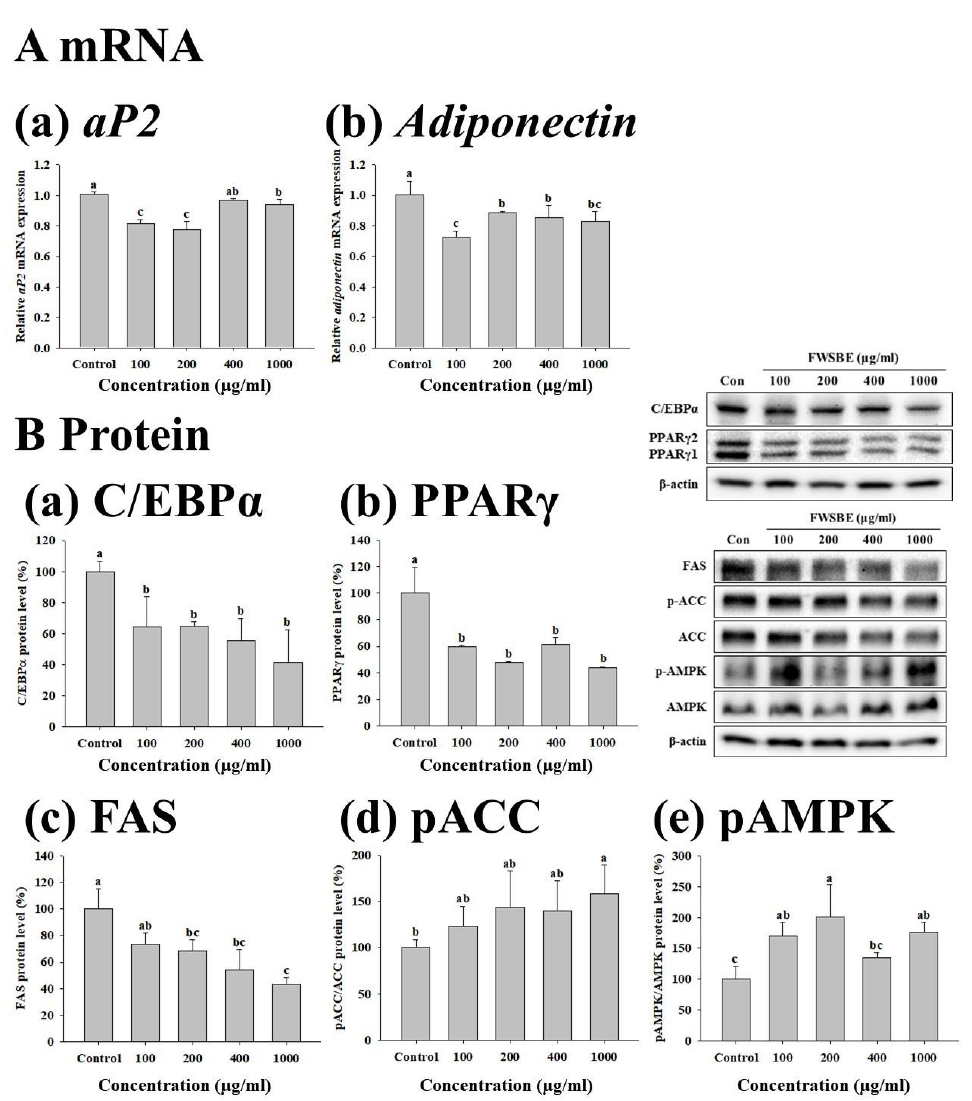
Figure 3. Effects of fermented white sword bean extract (FWSBE) on ( A ) the transcription level of (a) aP2 and (b) adiponectin and ( B ) the protein level of (a) C/EBP α , (b) PPAR γ , (c) FAS, (d) pACC, and (e) pAMPK on 3T3-L1 preadipocytes. The cells were treated with FWSBE at various concentration (100, 200, 400, and 1000 µ g/mL) for 48 h during differentiation. Values are presented as mean ± standard deviation. The statistically significant difference ( p < 0.05) between groups was determined by a one-way ANOVA and Duncan’s multiple range test. Different letters are used to indicate significant differences. C/EBP α , CCAAT/enhancer binding protein α ; FAS, fatty acid synthase; ACC, acetyl-coenzyme A carboxylase; PPAR γ , peroxisome proliferator-activated receptor γ ; and AMPK, AMP-activated protein